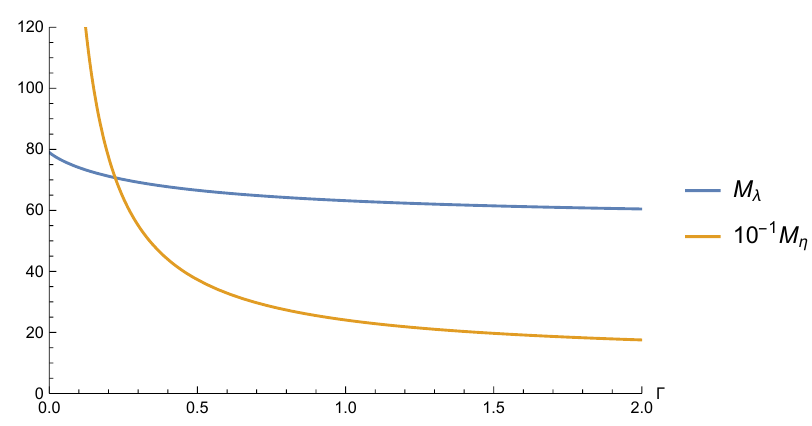
Figure 2 . Plot of the mass corrections (3.13) as a function of the ratio Γ = p/q . These are positive function that asymptote towards a finite positive value in the limit Γ → ∞ . To make this figure we set R 5 = p = 1